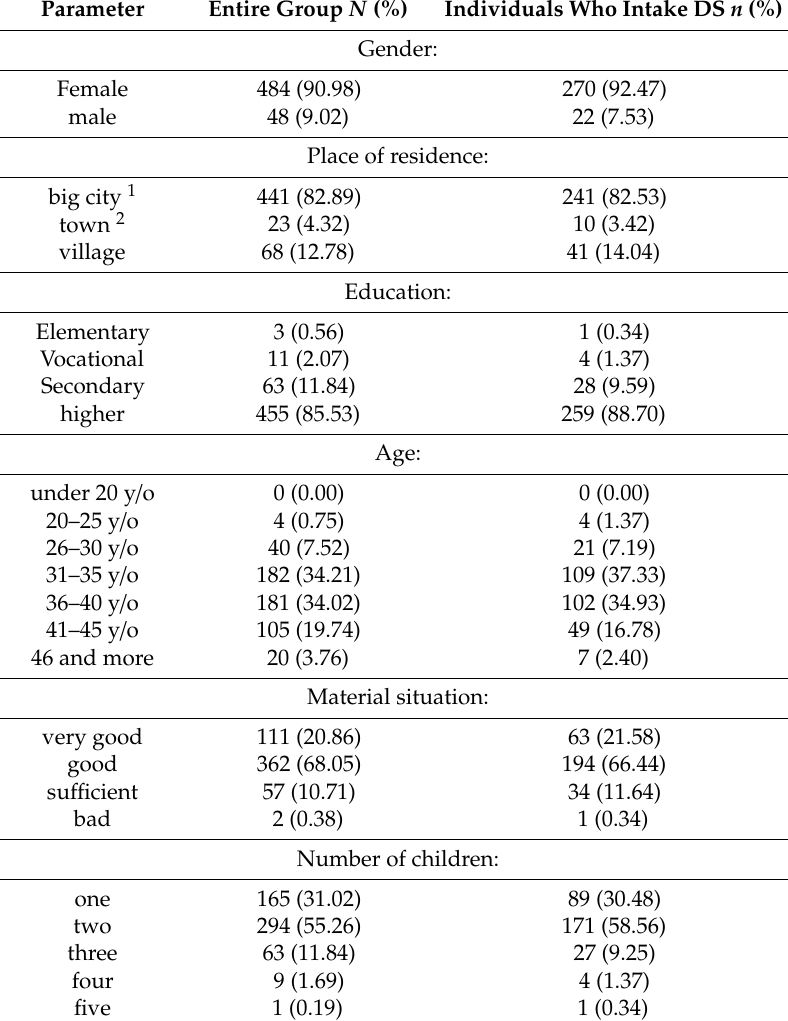
Table 1. Demographic characteristics of the study participants group.